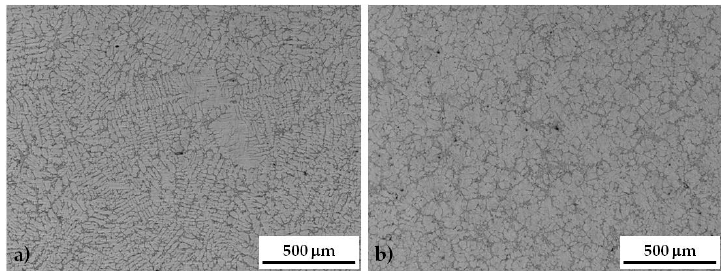
Figure 3. Optical microscope image of not ultrasound treated NUST ( a ) and ultrasound treated UST ( b ) sample microstructure.